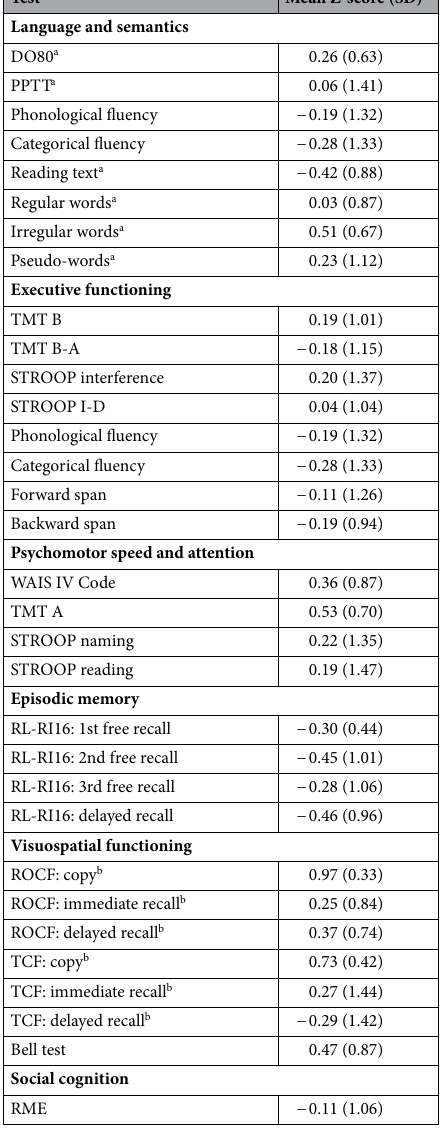
Table 1. Presurgical neuropsychological test results. DO80 Dénomination orale à 80 items, PPTT Pyramid and palm tree test, TMT trail making test, RL-RI16 Rappel libre rappel indicé, ROCF Rey–Osterrieth Complex Figure, RME read the mind in the eyes task, TCF Taylor Complex Figure, WAIS IV Wechsler adult intelligence scale IV. Data were available for 55 patients in language and executive functioning domain, for 48 patients in psychomotor speed and attention domain, for 40 patients in episodic memory domain, for 48 patients in visuospatial functioning domain and 28 patients in social cognition domain. Patients without presurgical RME evaluation were not evaluated with the RME task intraoperatively. a Some language tasks were assessed only for patients with left-sided tumors and/or left-handed patients. b Rey-Osterrieth and Taylor complex figures were randomly switched between the presurgical and postsurgical